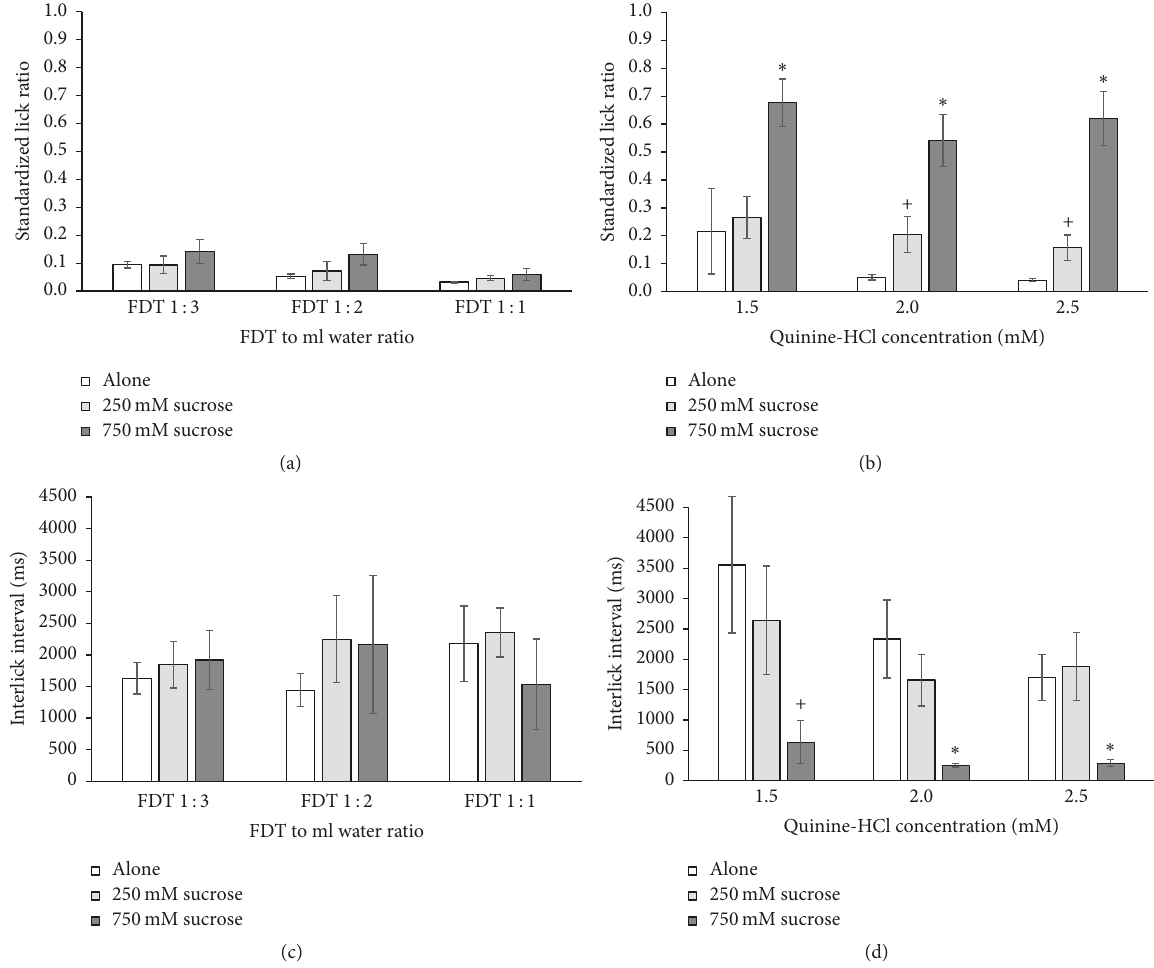
Figure 2: Average licks (a and b) and interlick intervals (c and d) to FDT (a and c) and quinine (b and d) with and without 250 mM or 750 mM sucrose as a masking agent with SEM represented in errors bars. (a) Sucrose did not increase licking to FDT+. (b) Star ( 𝑝 < .01 ) and plus ( 𝑝 < .05 ) symbols represent significant increases in licking when sucrose was added to quinine-HCl. (c) Sucrose did not affect the interlick intervals for FDT+. (d) Star ( 𝑝 < .01 ) and plus ( 𝑝 < .05 ) symbols represent significant decreases in the interlick interval when 750 mM sucrose was added to